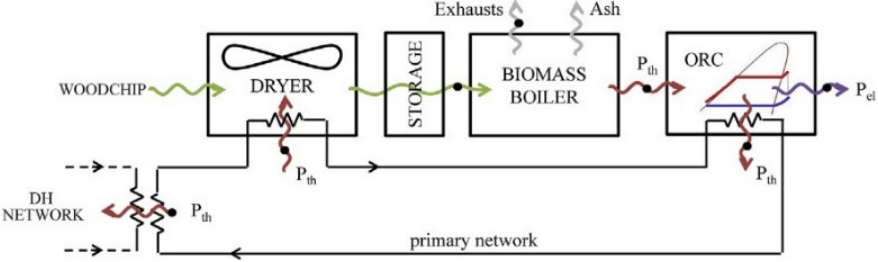
Figure 11. Structure of a biomass-fueled ORC system [93].